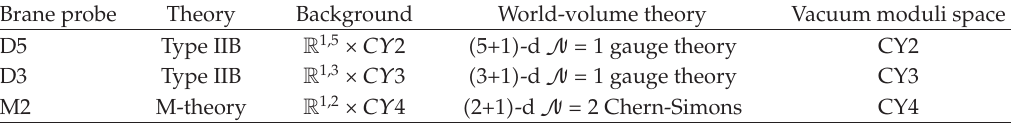
Table 1: Brane probes and associated world-volume physics in various